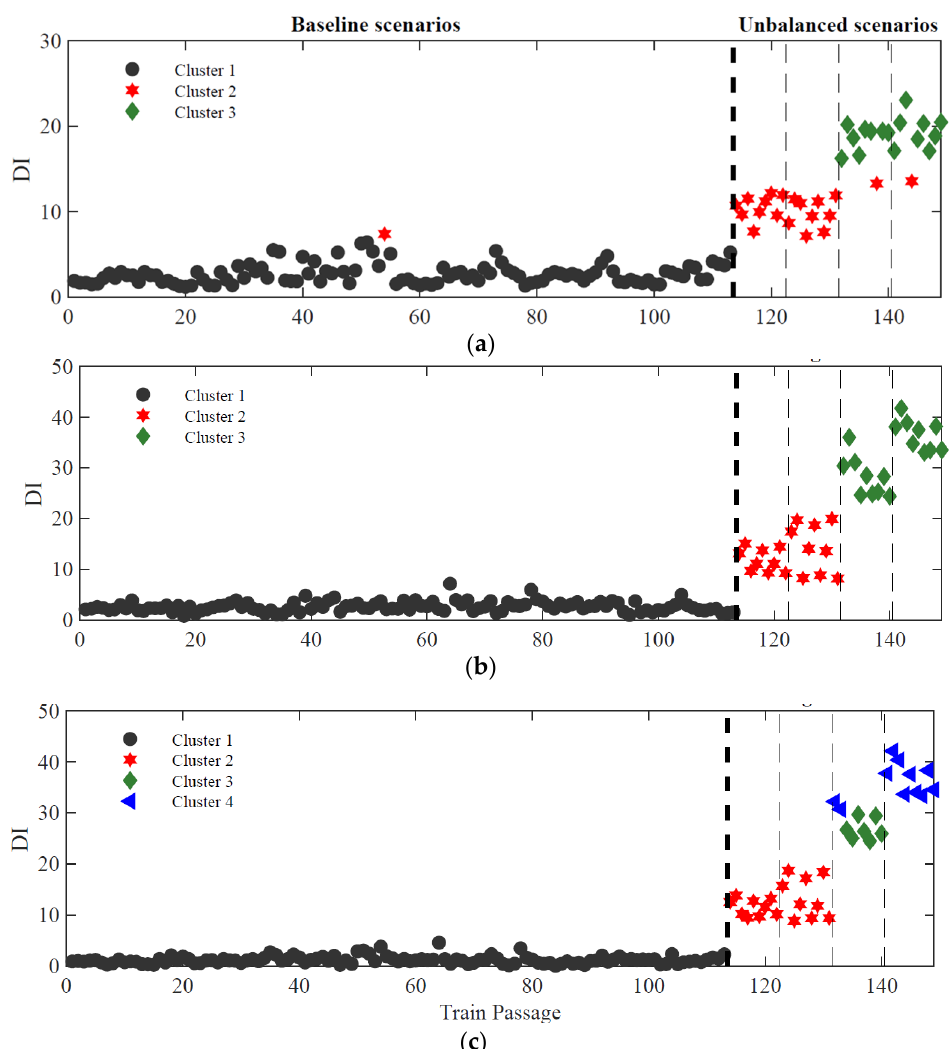
Figure 16. Cluster analysis for the PCA features: ( a ) 8 accelerometers; ( b ) 8 strain gauges; ( c ) 8 accelerometers + 8 strain gauges.